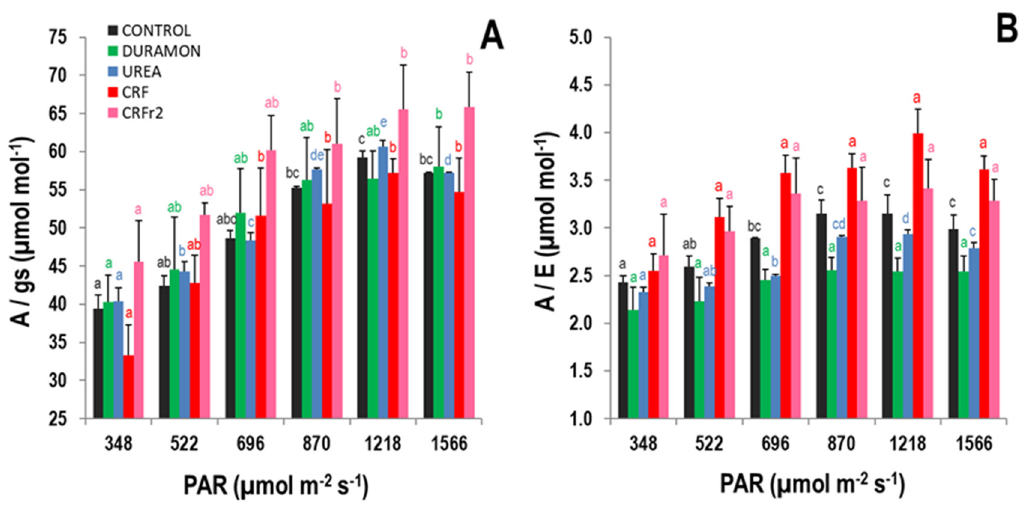
Figure 3. Water-use e ffi ciency responses, on the microscale experiment, to the di ff erent photosynthetically active radiation (PAR) rates of Oryza sativa treated with fertilizers CRF, CRF r2 , DURAMON ® , UREA, and the CONTROL (no fertilizer applied), in the phenological booting stage. ( A ) Water-use e ffi ciency and ( B ) intrinsic water-use e ffi ciency. Values represent means ± SD ( n = 5). Di ff erent letters (same color) indicate statistically significant di ff erences between di ff erent PAR levels for each treatment (ANOVA, p < 0.05).